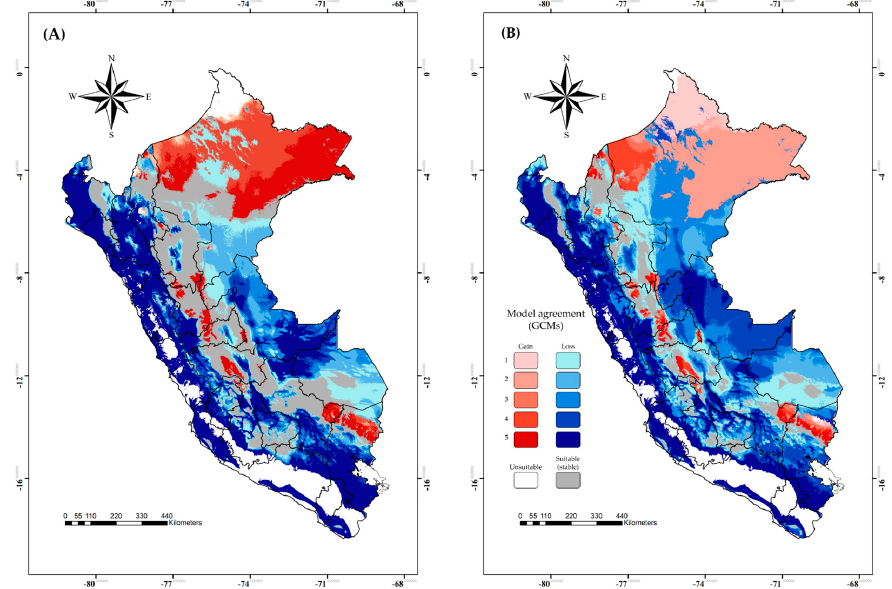
Figure 3. Comparison of binary models considering agreement among five GCMs for the potential geographic distribution of bluetongue virus based on the current and future climate in two distinct scenarios: ( A ) SSP126 and ( B ) SSP585. A blue scale means an agreement level of five GCMs which are no longer suitable, while a red scale denotes them being newly suitable. Gray color means suitable in the current climate scenario and for all GCMs, while white denotes being unsuitable in the current climate scenario and for all GCMs.